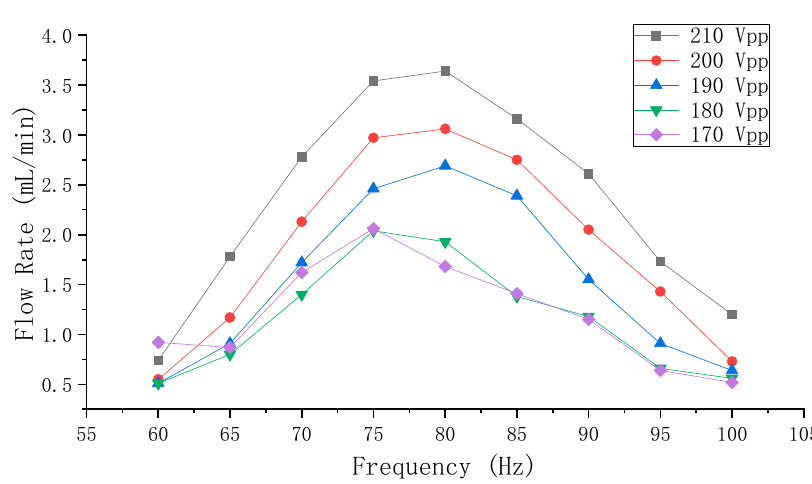
Figure 10. The flow rate results of the Group B PZT pump at the high frequency range.